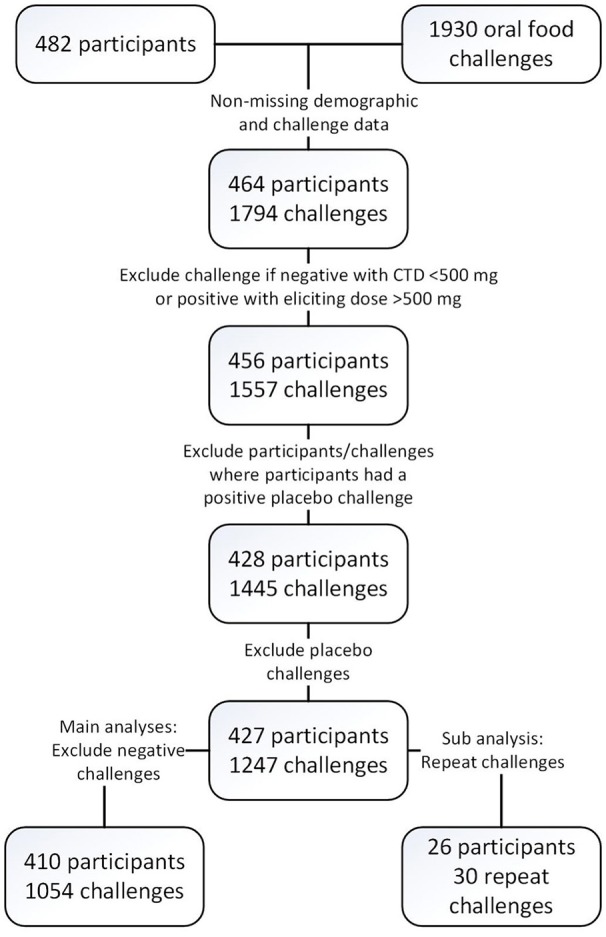
Consort diagram.